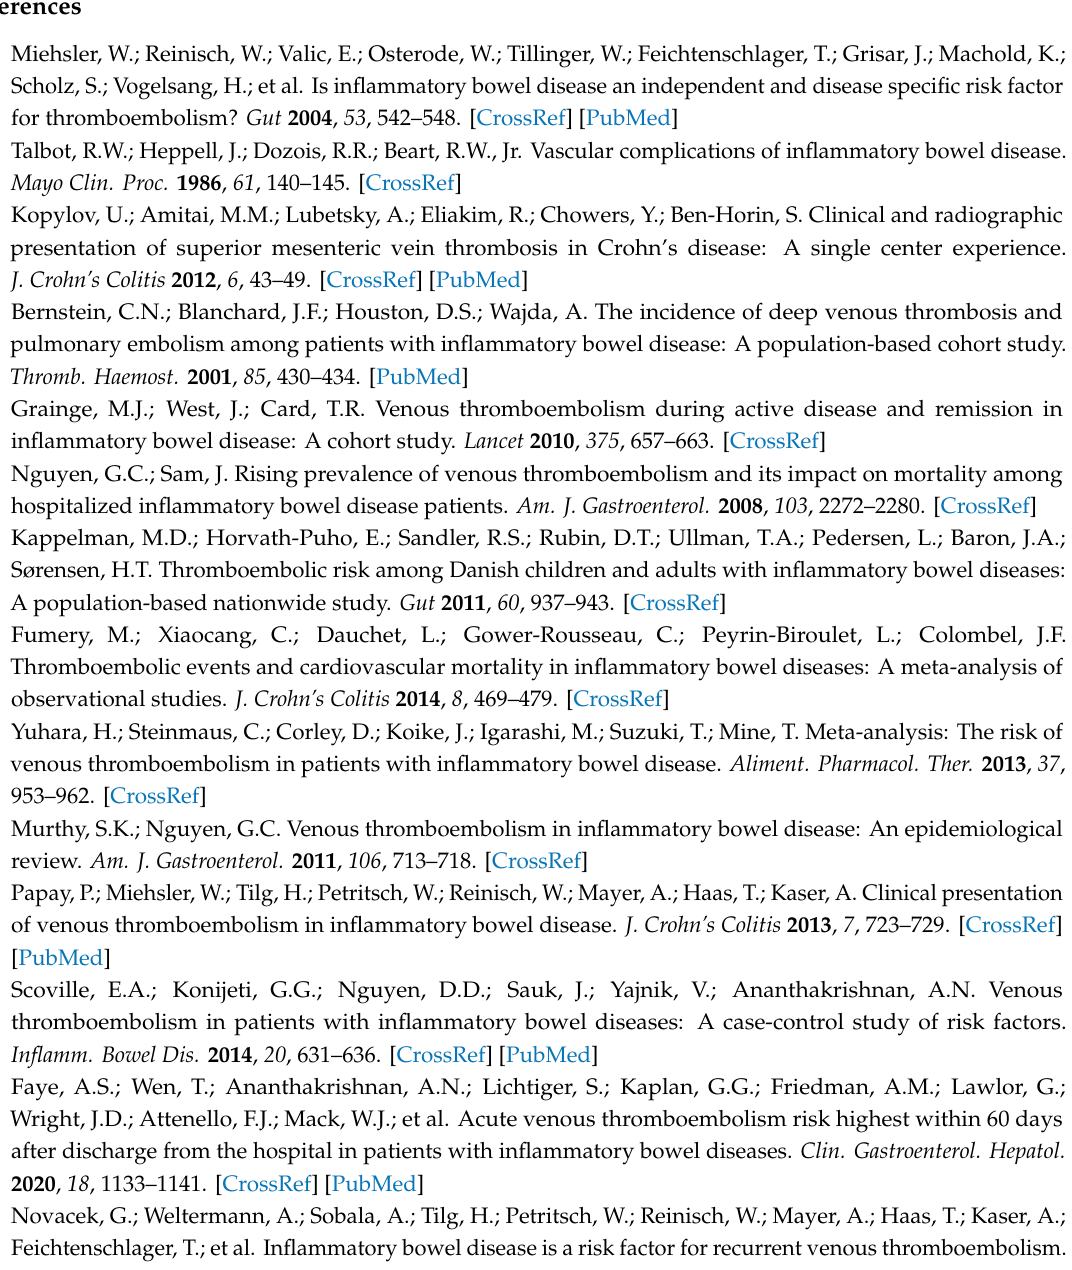
Table S1: Recent hospitalizations of current VTE